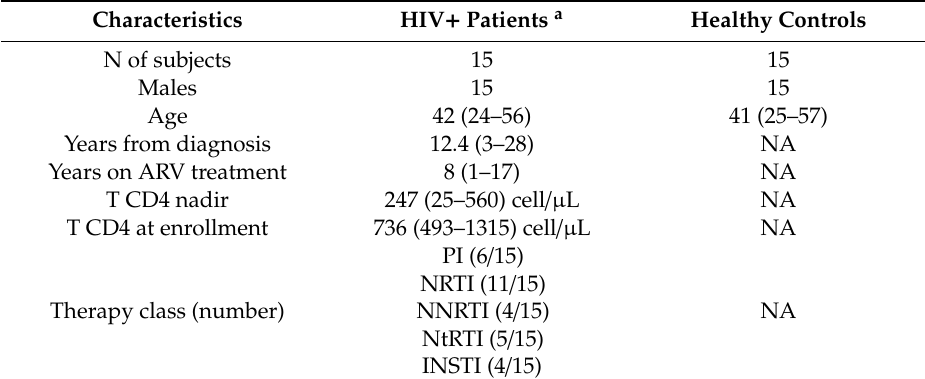
Table 1. Characteristics of HIV + subjects enrolled in the study.